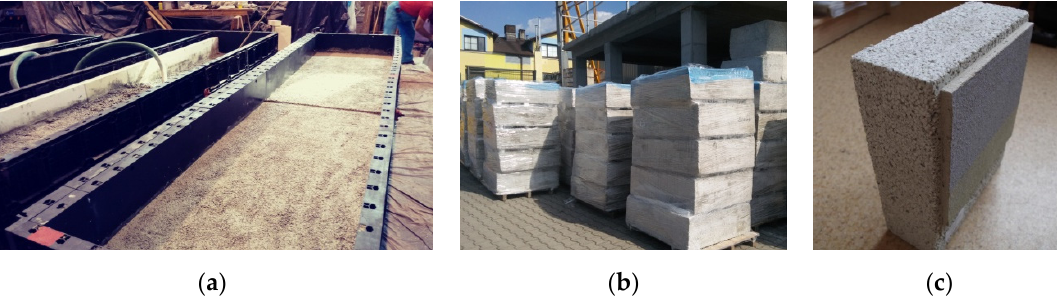
Figure 1. Selected stages of component production. ( a ) laying the mixture, ( b ) seasoning the boards, and ( c ) ready insulation panel.